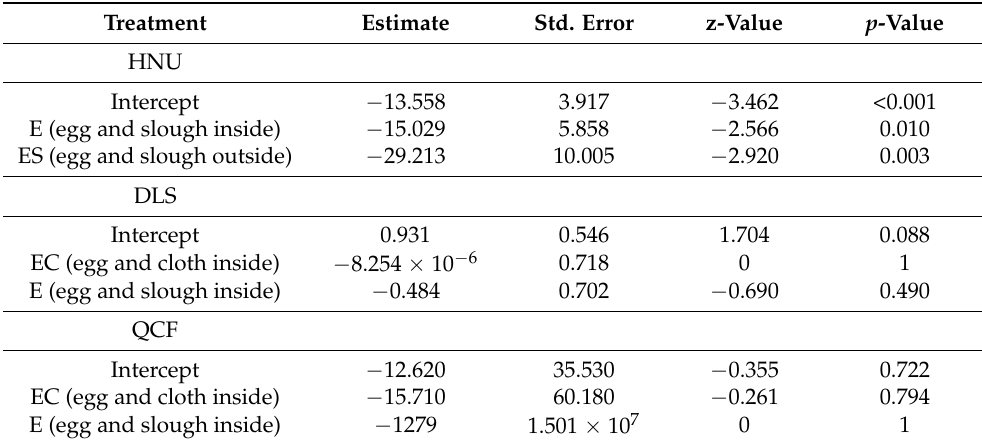
Table 2. Comparison of nest predation among different treatment groups at three regions by GLMM (the reference level was the control group